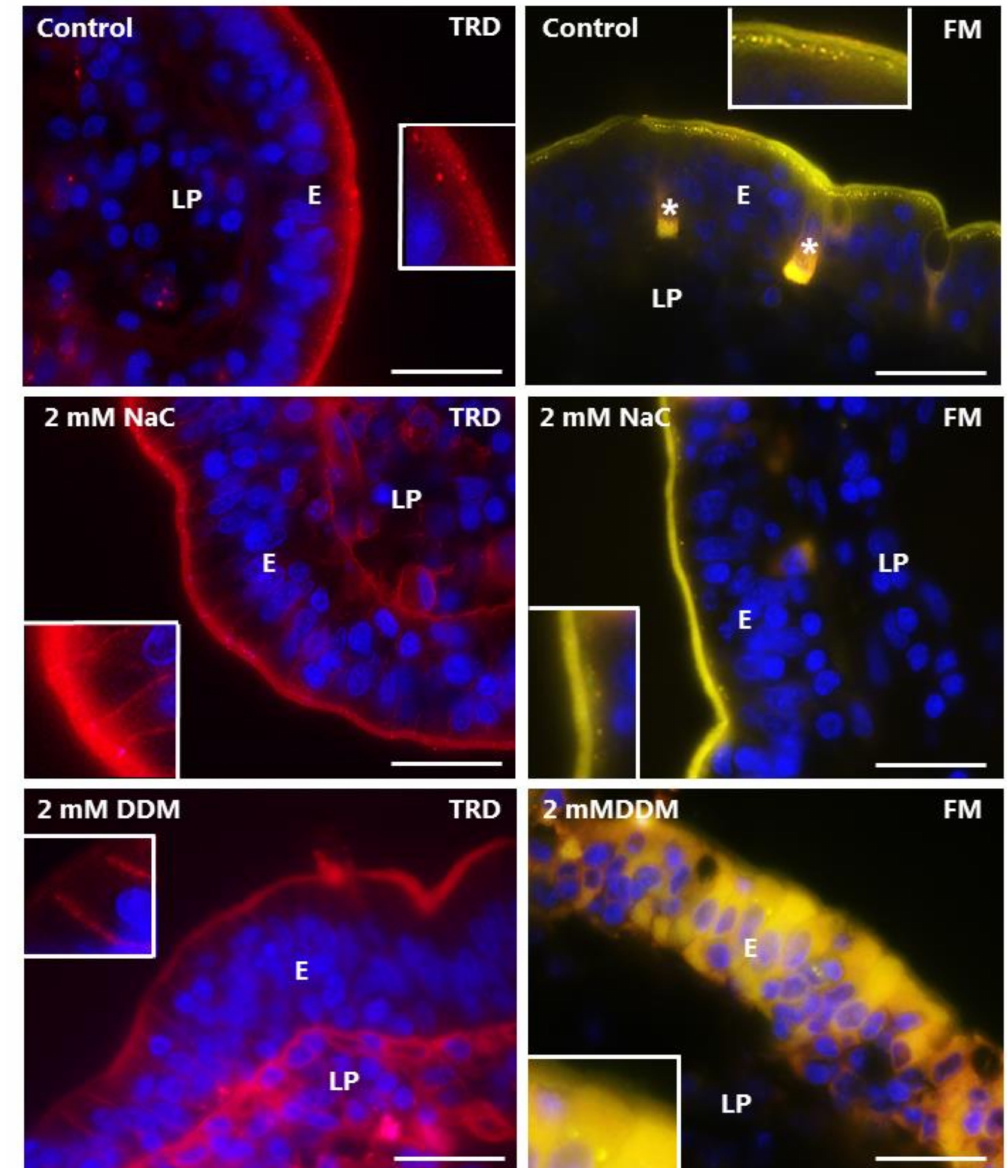
Figure 7. Permeability of the mucosal epithelium probed with TRD and FM. Sections of mucosal explants cultured for 1 h with TRD or FM in the absence or presence of 2 mM NaC or DDM, respectively. In the control, TRD bound to the enterocyte brush border, but only few and weakly-stained TRD-positive supapical punctae were observed. In addition, a faint labeling of the lamina propria was detectable. NaC and DDM both greatly increased the lateral TRD-labeling and accumulation of the probe in the lamina propria without affecting TRD-binding at the brush border, but little if any leakage was seen into the cytosol of the enterocytes. Like TRD, FM strongly labeled the enterocyte brush border, and also appeared in bright subapical punctae in the control. The brush border labeling was generally unaffected by both surfactants, but subapical punctae were sparse. Occasionally, FM was absent from the brush border, but leaked into the cytosol of enterocytes, as shown for DDM, but no staining of the lamina propria was observed. (Asterisks show goblet cells labeled by FM and inserts show enlarged image details.) Bars: 20 µ